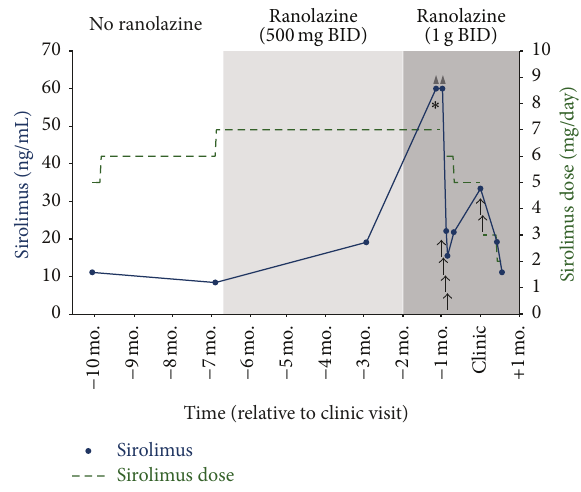
Sirolimus Sirolimus dose Figure 1: Timeline of sirolimus dosing and whole blood concen- trations with ranolazine titration. 󳵳 : level above limit of detection; ↑ : sirolimus held for 1 day; ∗ : patient presents to emergency